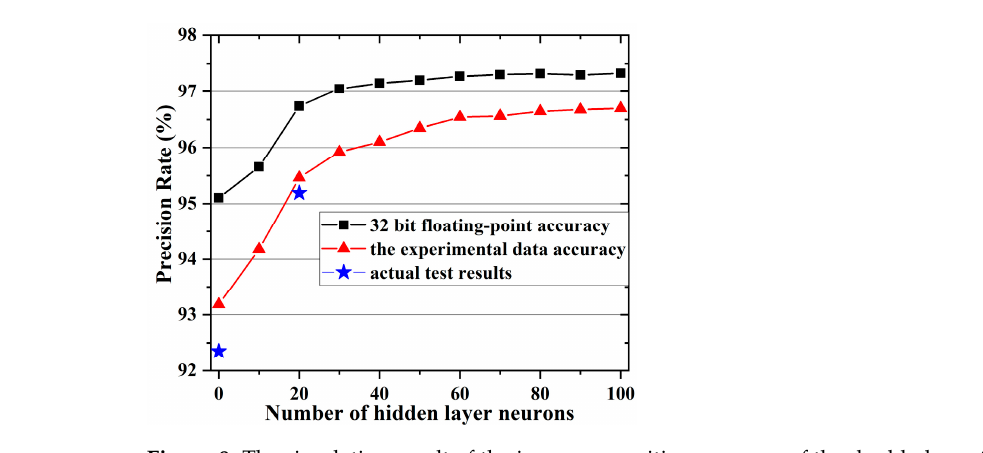
Figure 8. The simulation result of the image recognition accuracy of the double-layer fully connected network changes with the number of neurons in the hidden layer.